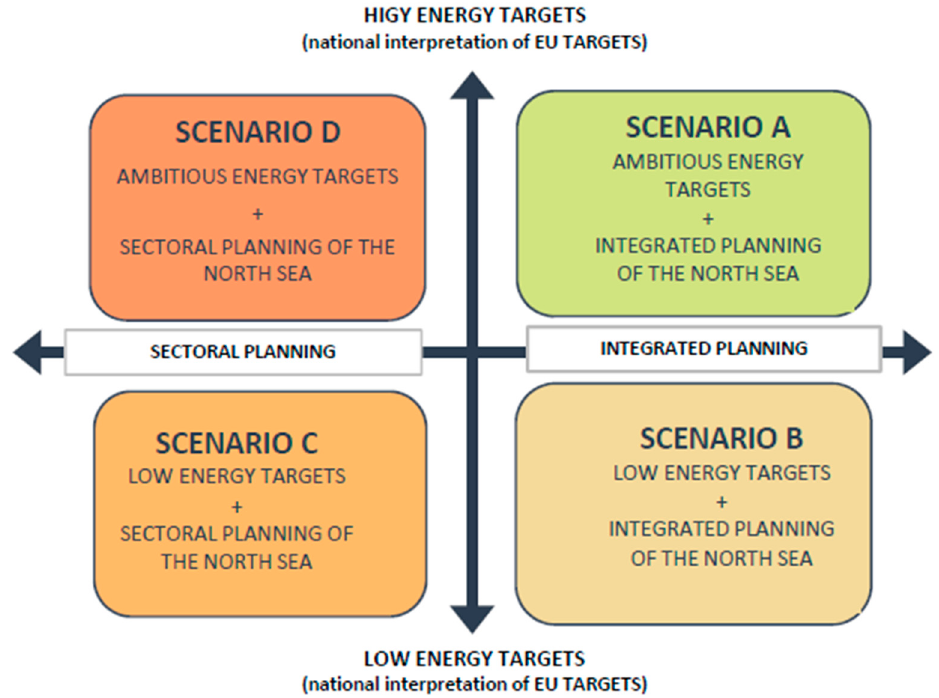
Figure 3. Scheme of scenarios for the deployment of renewables, up to 2050.